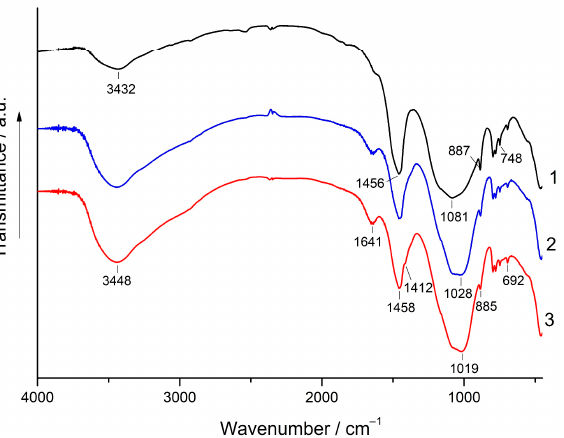
Figure 14. The FT-IR spectra: 1—the (90% FA + 10% magnesite) blend milled for 180 s, 2 and 3—the geopolymer synthesized using this blend after 7 and 28 d of curing, respectively.